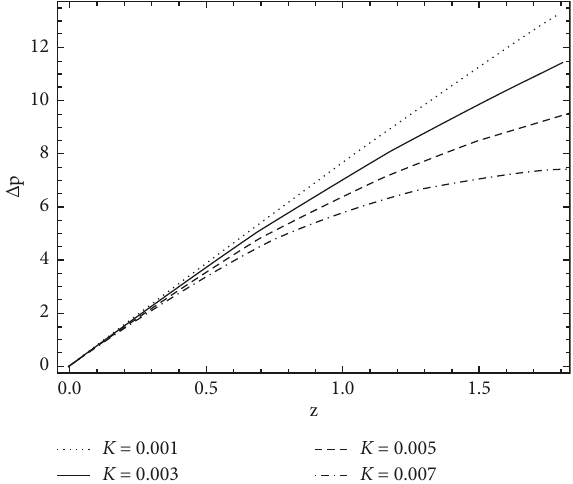
Figure 7: Variation of ∆ p with z for different values of K , where P 0 � 43, We 2 � 0.01, n � − 1, and m �